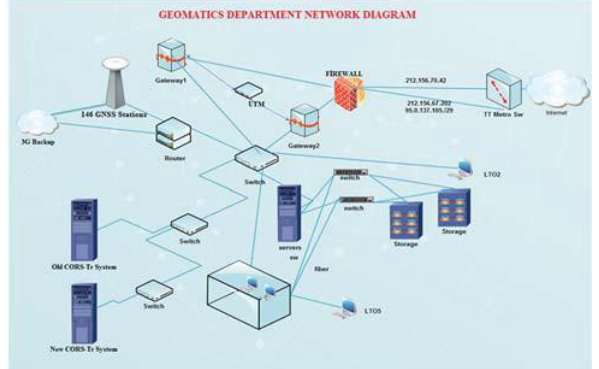
Figure 3- Geomatic Department Network